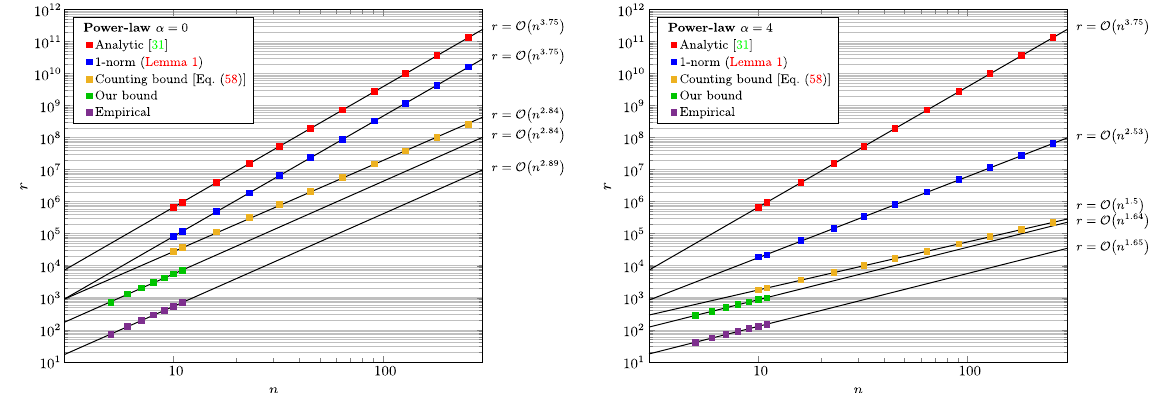
FIG. 4. Comparison of r for the power-law Heisenberg model using the analytic bound (see Proposition F.4 of Ref. [31]), 1-norm bound (Lemma 1), a bound from counting argument (58), and our bound (Proposition M.2). Error bars are omitted as they are negligibly small on the plot. Straight lines show power-law fits to the data. Note that the exponent for the empirical data is based on brute-force simulations of small systems and thus may not precisely capture the true asymptotic scaling due to finite-size effects.